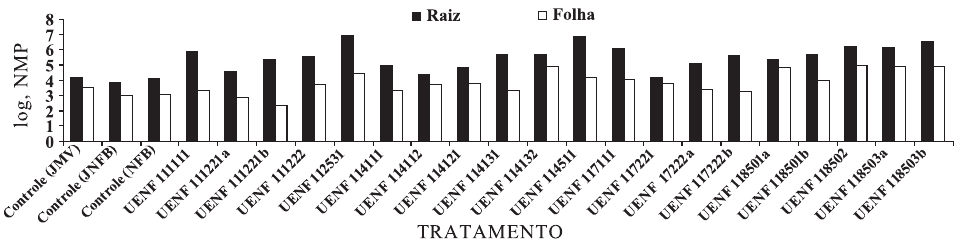
Figura 3. Log do Número Mais Provável (NMP) de bactérias por grama de raiz e de folha D do abacaxizeiro ‘Vitória’ em resposta à inoculação de bactérias diazotróficas endofíticas e